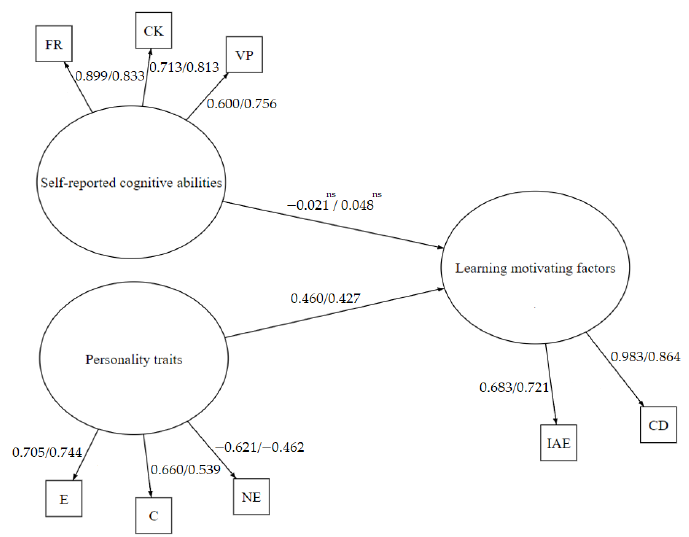
Figure 3. Standardized results of model on associations between learning motivating factors, self- reported cognitive abilities, and personality traits in both groups of participants and non-participants of computer programming e-learning based courses. IAE: individual attitude and expectation; CD: clear direction; E: extraversion; C: conscientiousness; NE: negative emotionality; FR: fluid reasoning; CK: comprehension-knowledge; VP: visual processing; ns: non-significant. Table 11. Scalar estimates of the model on associations between learning motivating factors, self-reported cognitive abilities, and personality traits in both groups of participants and non-participants of computer programming e-learning based